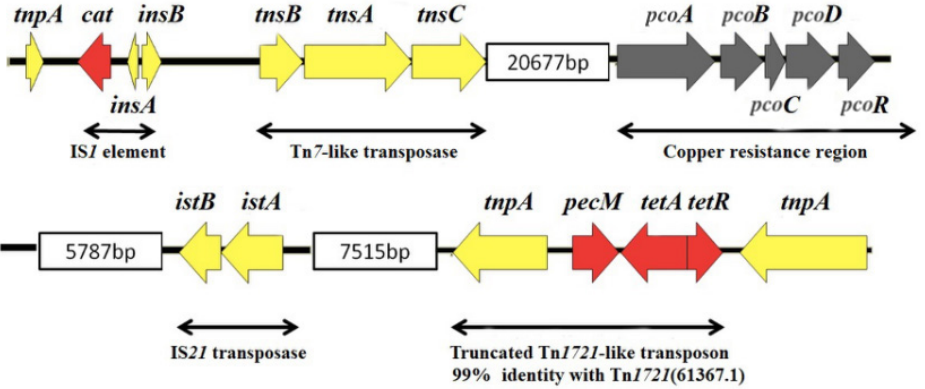
Figure 2. Schematic diagram of RR2. The red arrows in the figure represent the drug-resistance gene cassettes, the yellow arrows represent the genes associated with the transposition function, and the dark gray arrows represent the heavy metal resistance genes. The size of the arrow is in proportion to the size of the coding gene and the length of the RR2 gene sequence.